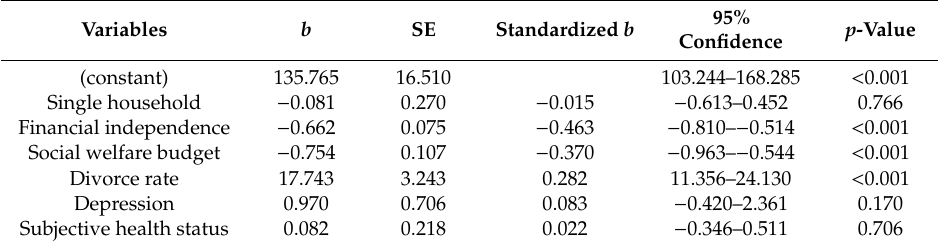
Table 4. Associated factors in regional variations in suicide